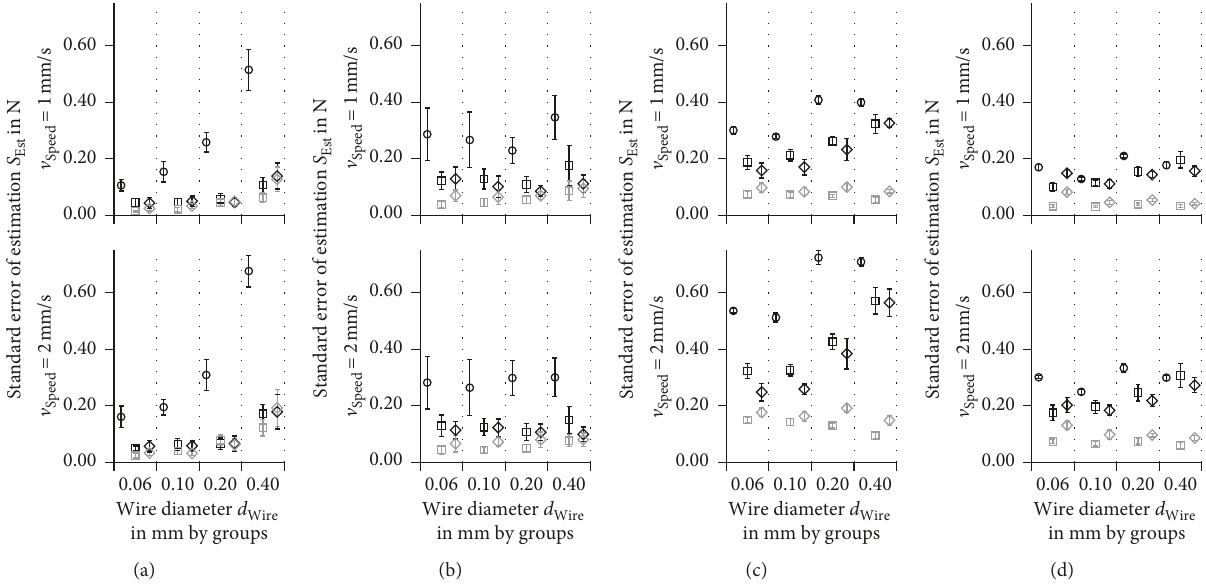
F IGURE 9: Plot of the standard error of estimation S Est in respect to the wire diameter d Wire . The error for F MD is shown in black and for F CD in grey. The circles represent λ � 0 ° , rectangles for λ � 30 ° , and rhombus for λ � 45 ° . The error bars represent the standard deviation of measurements. (a) Edam Cheese. (b) Leberk¨ase. (c) Bubble gum 1. (d) Bubble gum